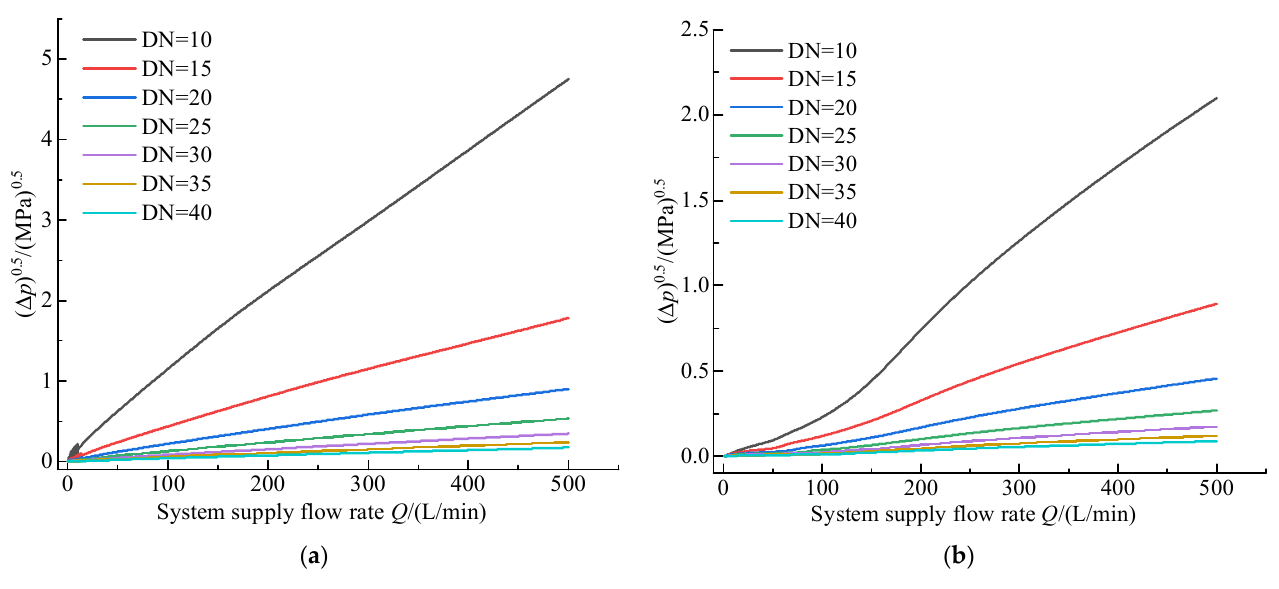
Figure 8. Relationship between supply flow and pressure drop of pipelines with different diameters: ( a ) Relationship between square root of pressure drop in inlet pipeline and supply flow; ( b ) relationship between square root of pressure drop in outlet pipeline and supply flow.